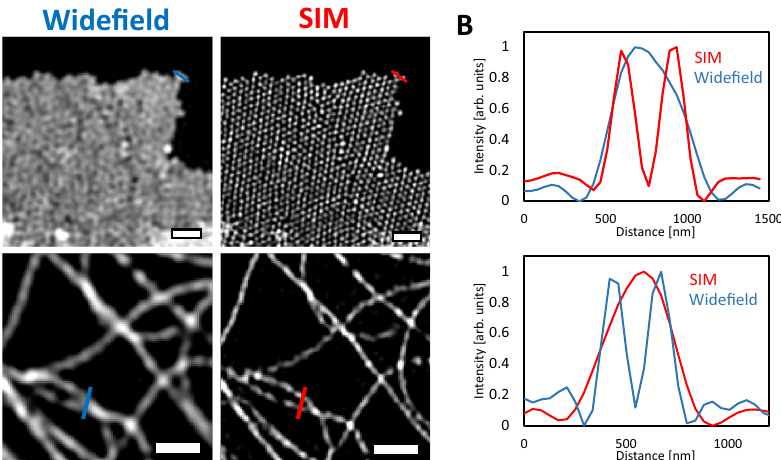
Fig. 2 | Demonstration of the MAI-SIM on samples excited at a wavelength of 561nm. In the deconvolved wide fi eld images, adjacent 200nm beads ( N =4, top) and entangled microtubule fi laments ( N =3, bottom) remain unresolved but are